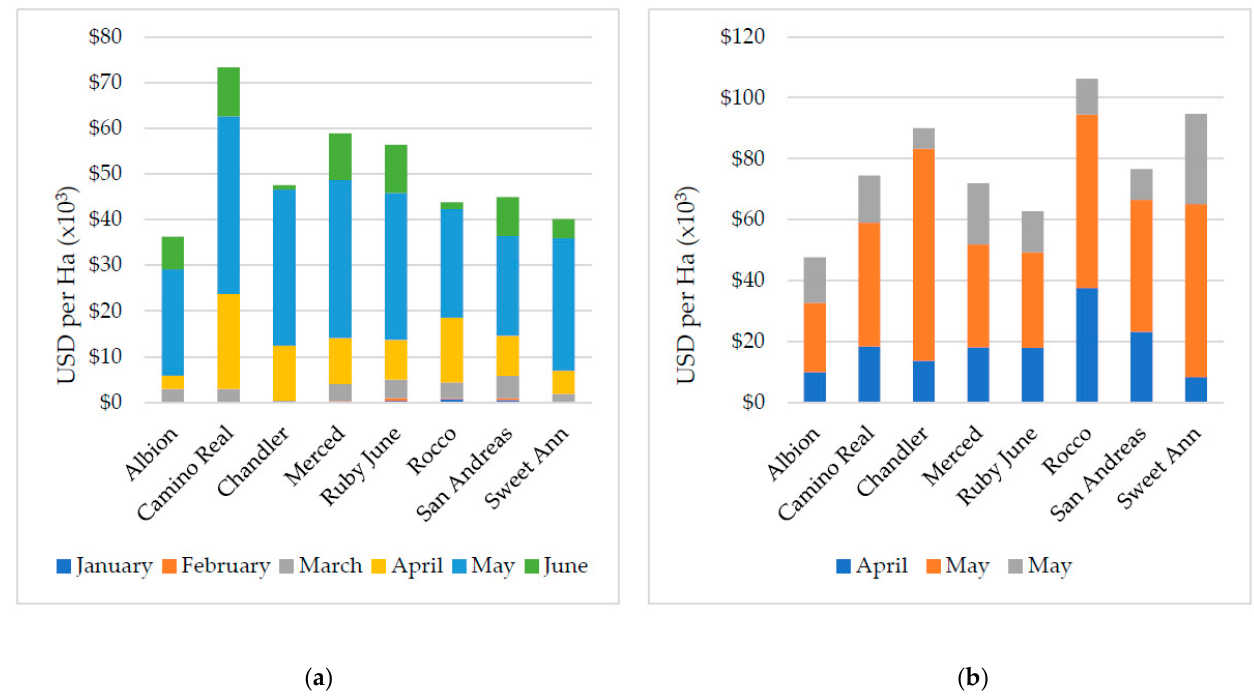
Figure 1. High tunnel ( a ) and open-field ( b ) gross revenues in USD per hectare for eight strawberry cultivars marketed at a wholesale price.